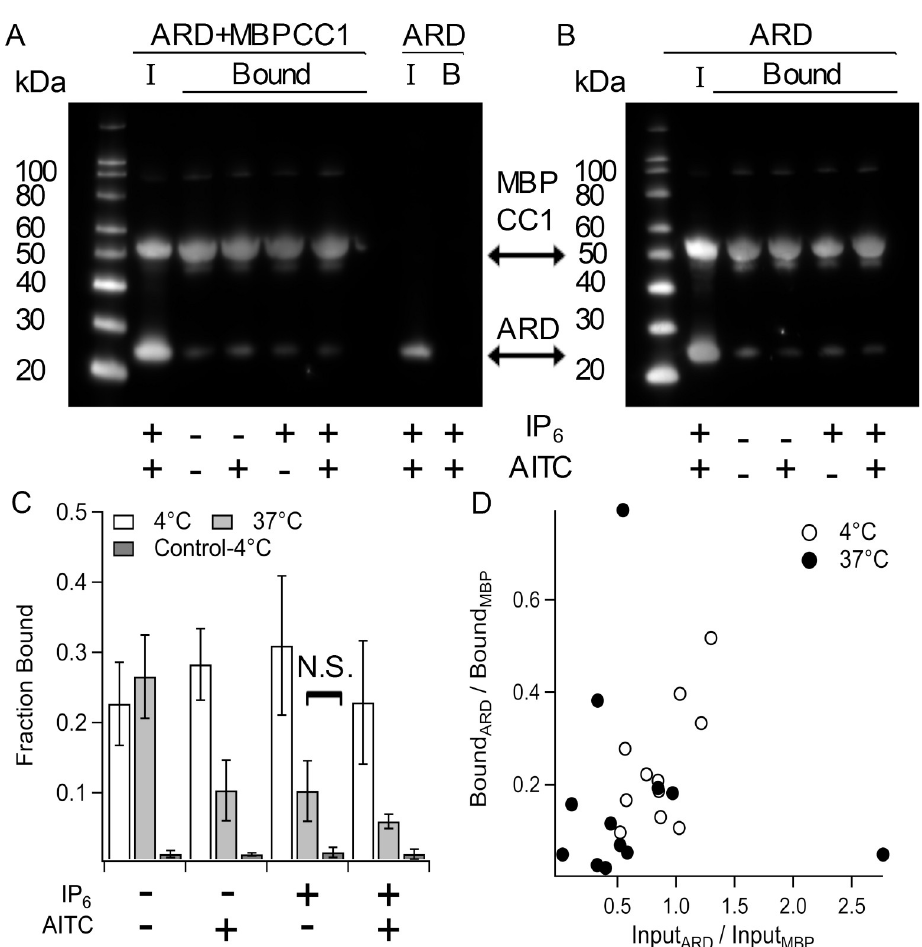
Fig 5. Interaction of MBPCC1 with the N-terminal ARD. A and B. Anti-His Western blots of amylose-resin purified protein from bacteria expressing both ARD and MBPCC1 or ARD alone. Incubation with resin and subsequent washing of resin was carried out at 4˚C (A) or 37˚C (B). “I” indicates input sample and “Bound” indicates protein pulled down that remained after 4 wash steps. At each temperature lysates were incubated with IP6 and/or AITC. C. Fraction of ARD bound to MBPCC1 normalized to input (see methods). Control indicates amylose purification of cells only expressing ARD at 4˚C. D. Bound ARD/MBP ratio vs Input ARD/MBP ratio showing that more ARD in the input correlates with increased ARD binding to MBPCC1 during purification. Except for the one indicated condition, all differences were significant (p < 0.05).